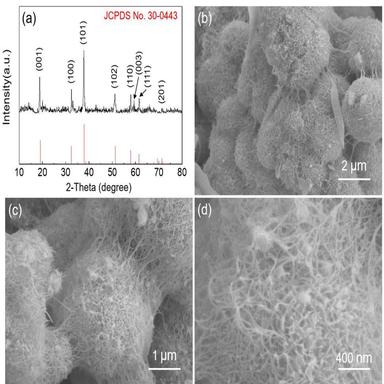
(a) XRD pattern of β-Co(OH)2 microclews, and (b-d) SEM images of β-phase Co(OH)2 microclews in different magnifications.